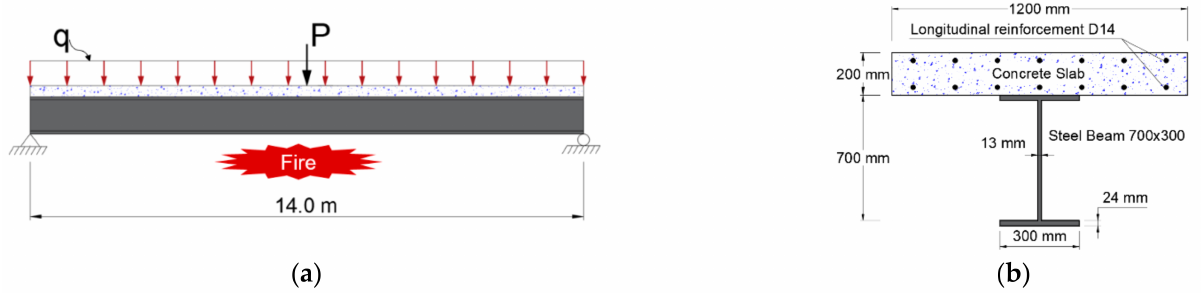
Figure 9. Composite beam used in analysis: ( a ) Boundary and loading conditions; ( b ) Cross-section of composite beam. Table 2. Properties of composite